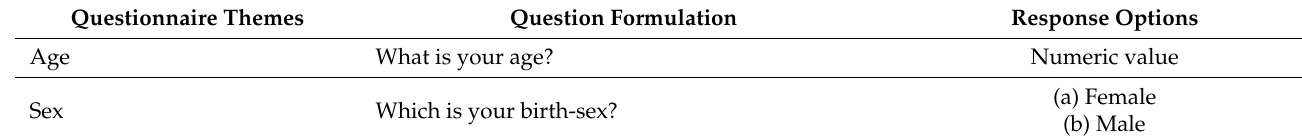
Table 1. Survey questions and response